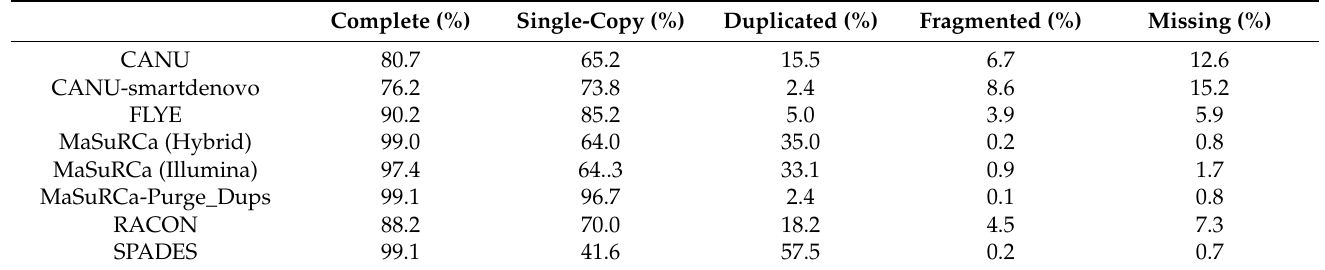
Table 3. Completeness assessment of Trametes villosa CCMB561 assemblies using BUSCO